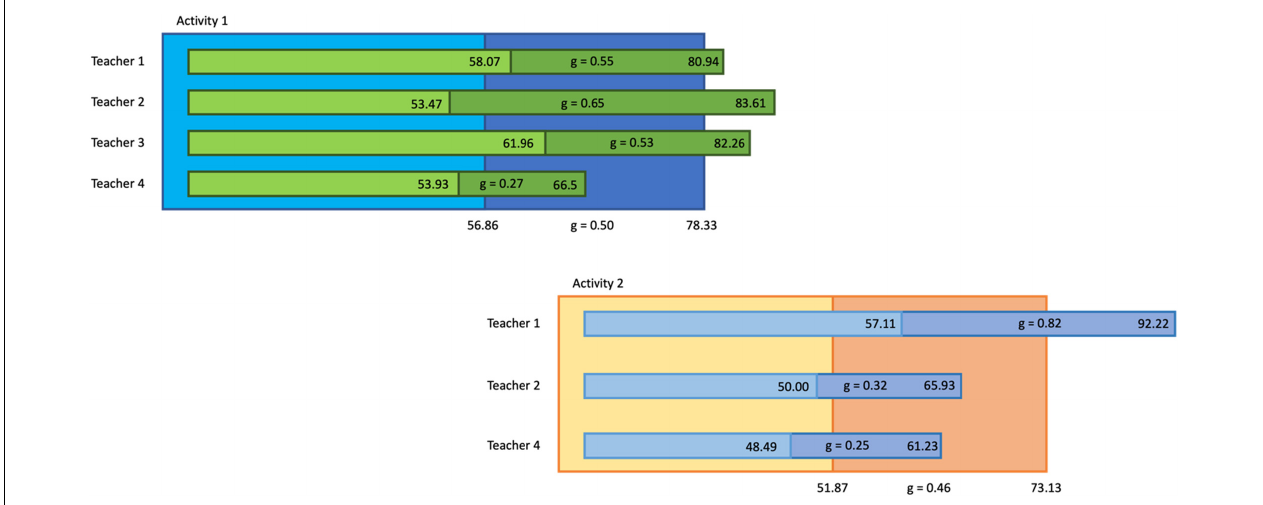
• Design objects that model reality. As part of Activity 1, using Lumen, students designed a cookie jar, made up of quadratic surfaces.